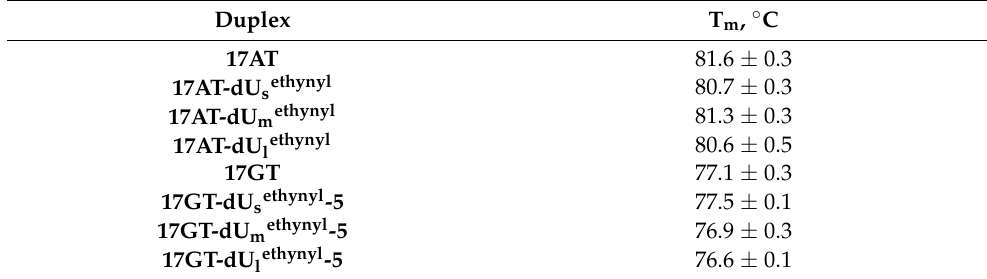
Table 2. Thermal stability of modified DNA duplexes *.